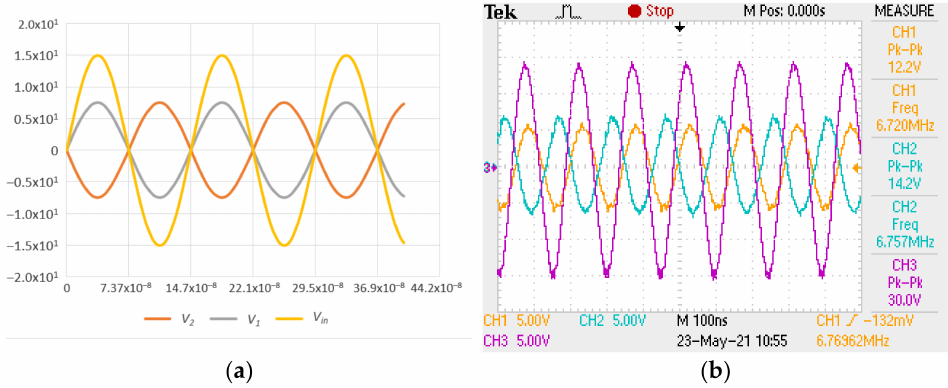
Figure 15. Voltage output and input of the balun. ( a ) Simulation. ( b ) Experiment.